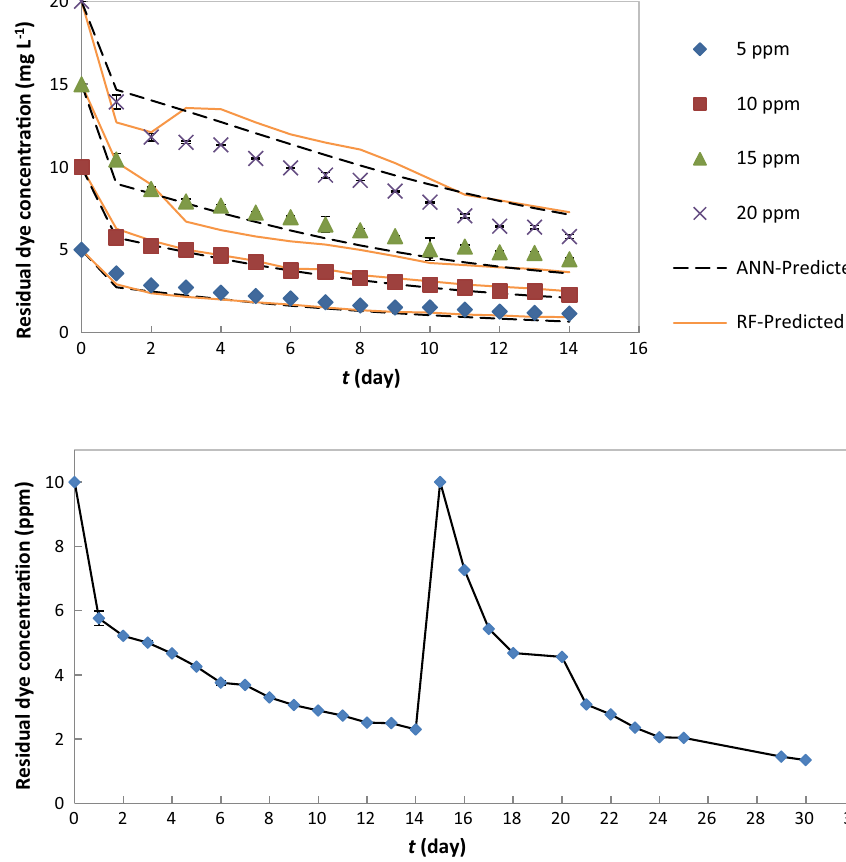
Fig. 4 Experimental data of the effect of initial dye concentra- tion the phytoextraction of RB using AP, in comparison with those predicted by ANN and RF models